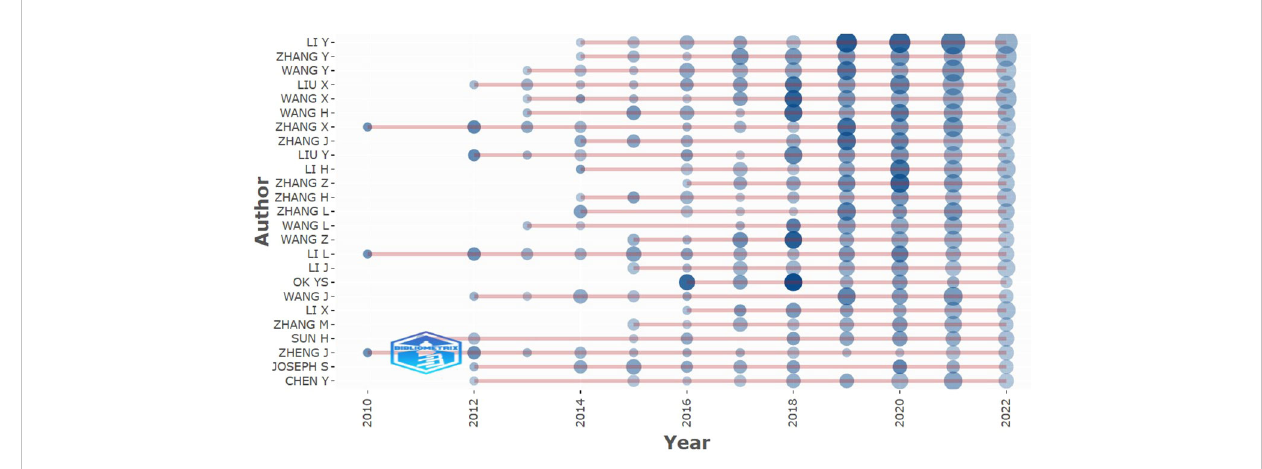
FIGURE 3 Top twenty- fi ve authors ’ production over time on biochar-based smart